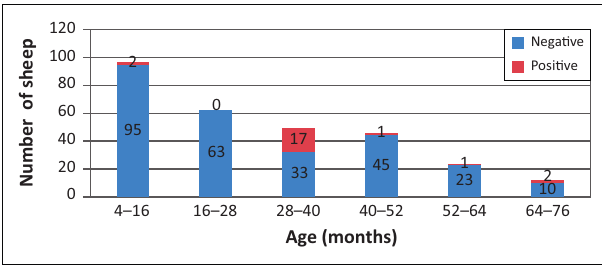
FIGURE 2: Seroprevalence of Toxoplasma gondii antibodies in a sample of sheep, organised according to